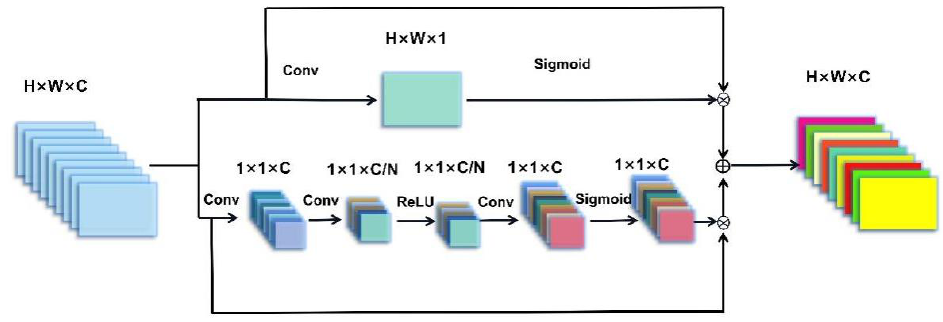
Figure 3. Channel attention mechanism network model.